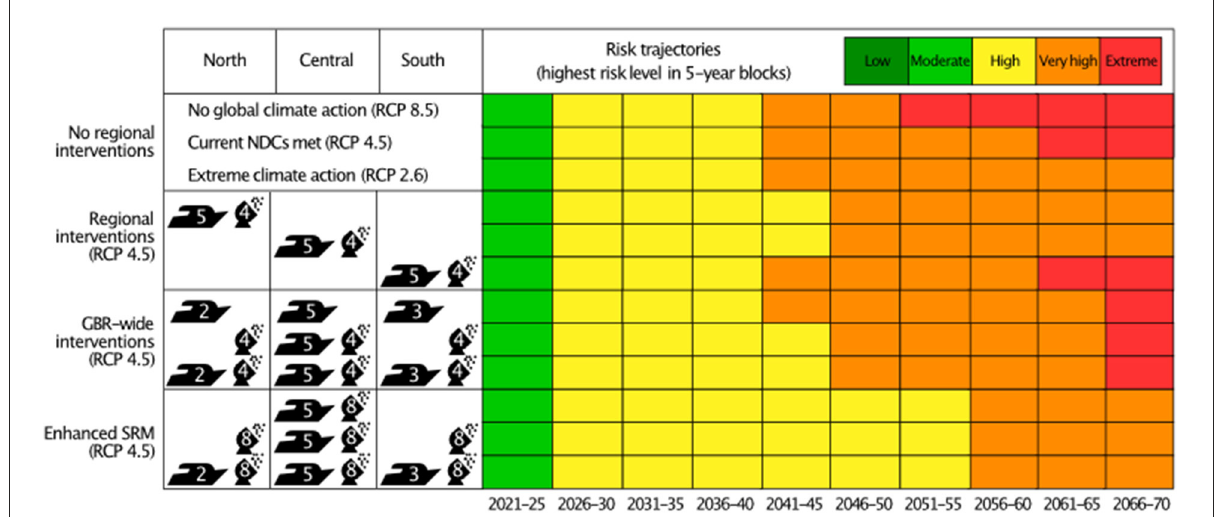
FIGURE5 Risk trajectories based on the highest risk level for each 5-year time block over the period 2021–2070 read directly from the risk matrices in Figure 3C (no regional interventions) and Figures 4A–C (regional interventions). The selected risk level descriptors (and colors) are only illustrative and can be modified to align with the objectives of any risk